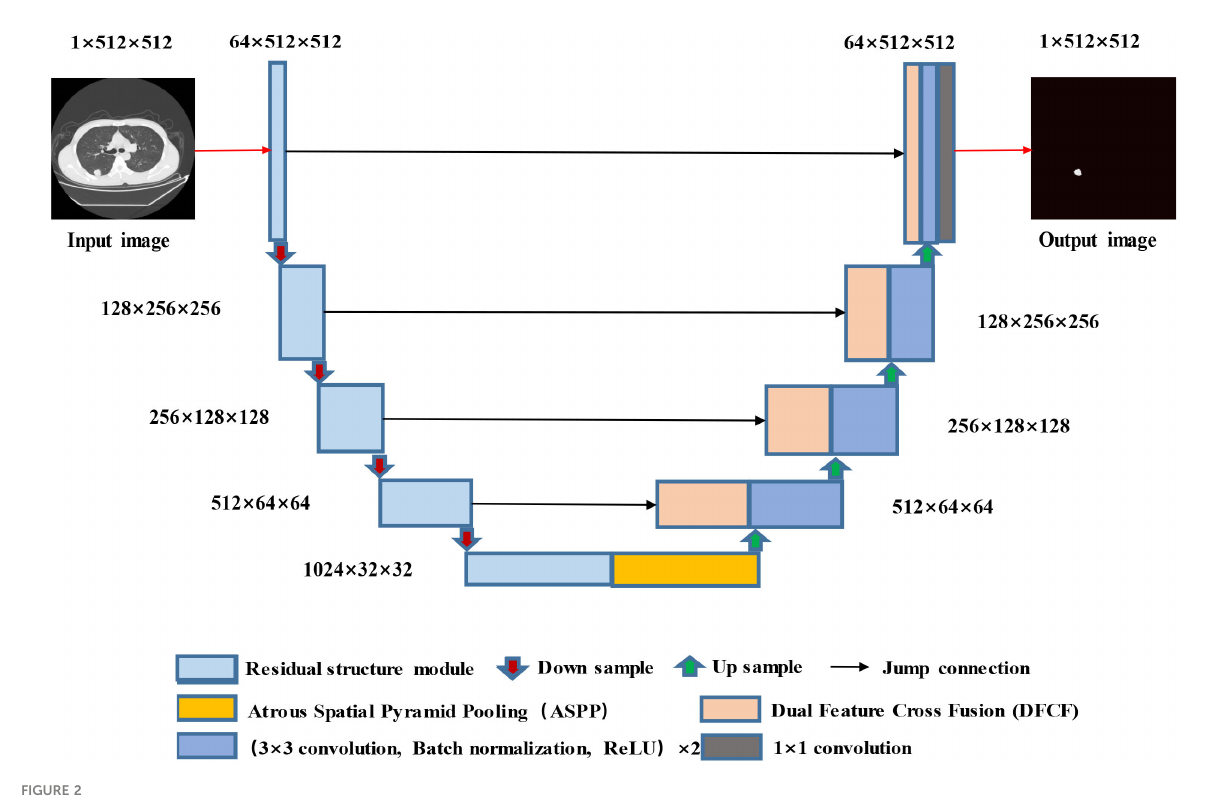
FIGURE 2 Structure diagram of the RAD-UNet convolutional neural